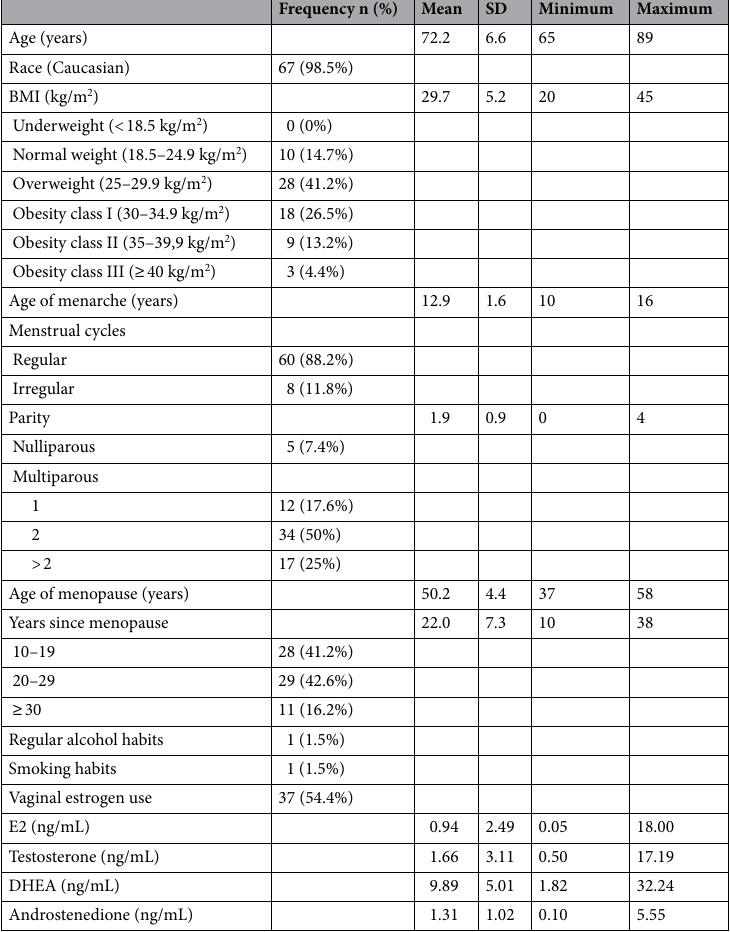
Table 1. Demographic characteristics and mean hormone levels of the participants (n = 68).